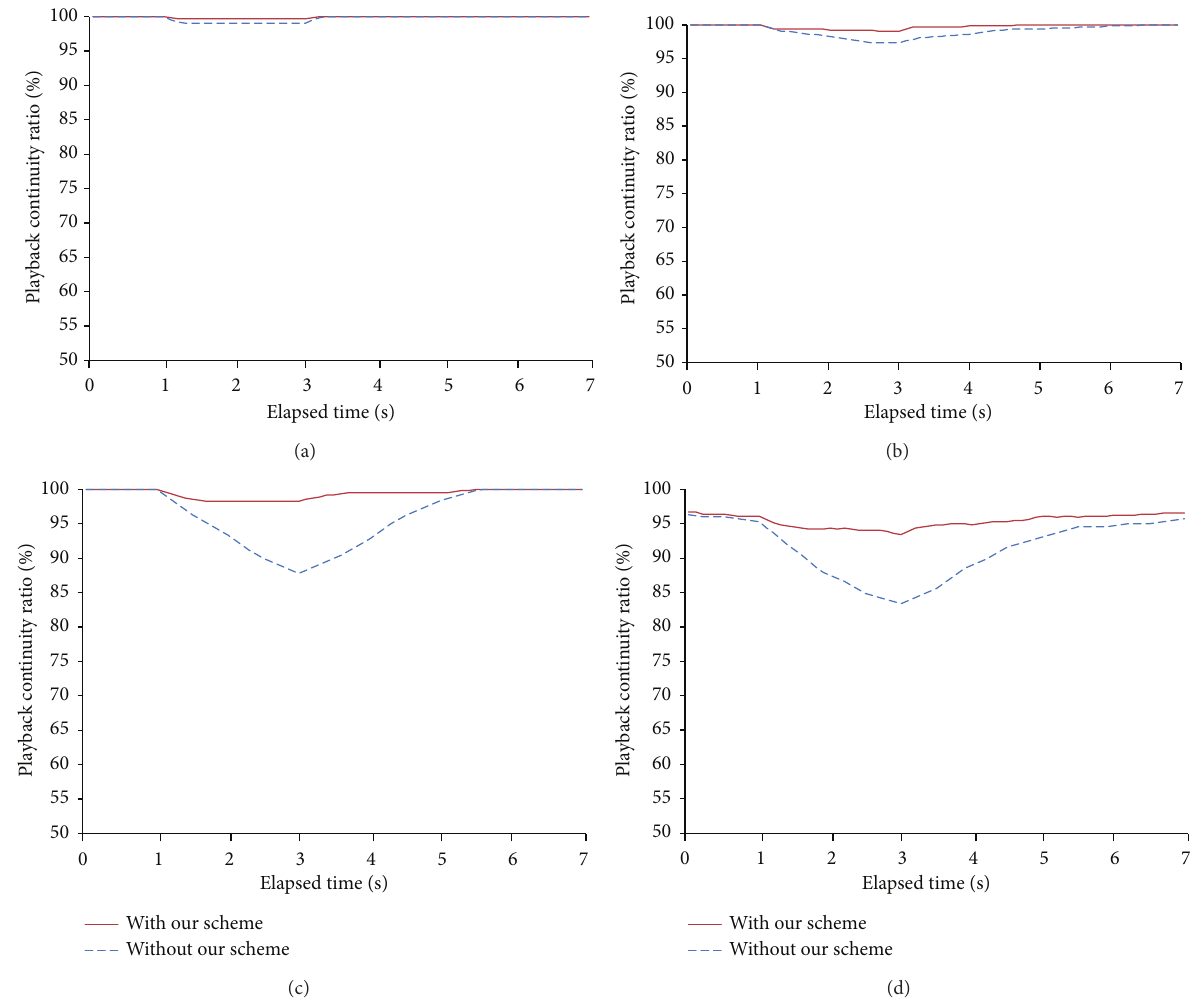
Figure 3: Playback continuity ratios of two cases according to effective wireless network bandwidth: (a) with effective bandwidth of 16Mbps, (b) with effective bandwidth of 14 Mbps, (c) with effective bandwidth of 12Mbps, and (d) with effective bandwidth of